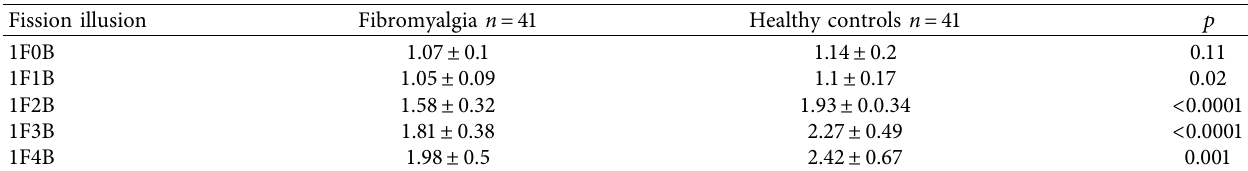
Table 2: Comparison of the fission illusion conditions between patients with fibromyalgia and healthy controls. Data are plotted in the Figure 1(a).